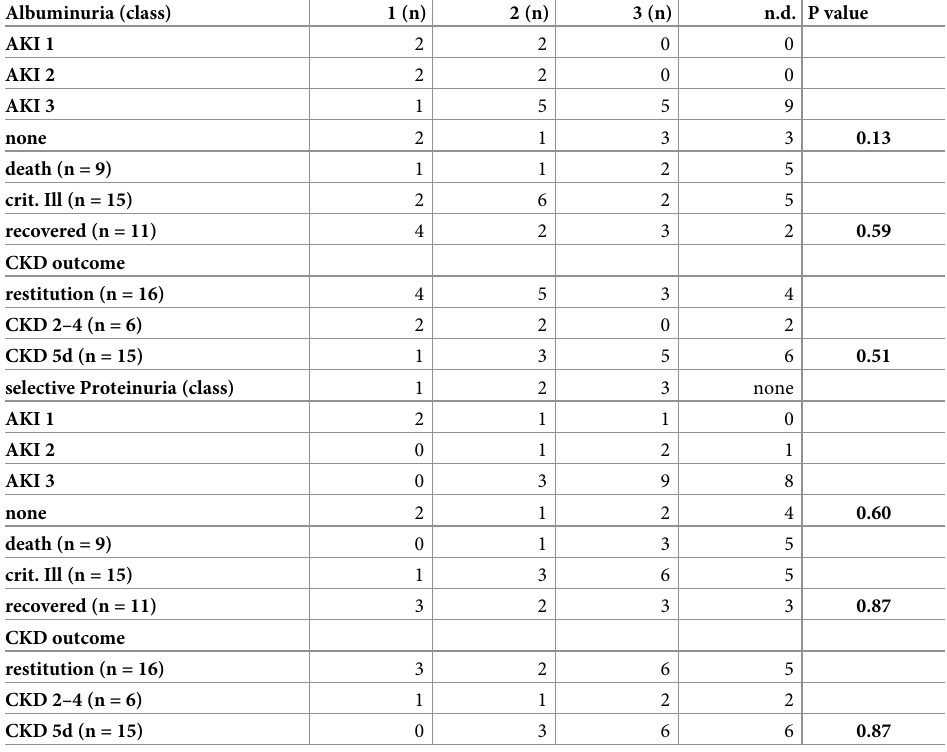
Table 2. Patients in the individual classification groups of albuminuria and non-selective proteinuria regarding AKI, outcome and